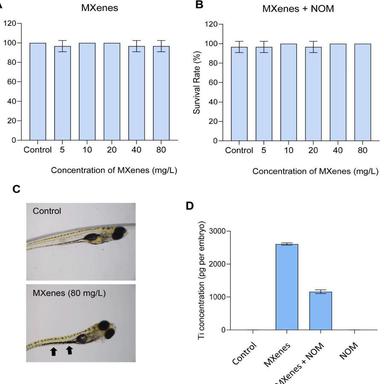
Survival rate of zebrafish embryos after exposure in EPA VS medium for 24 h to (A) MXenes alone, and (B) MXenes plus NOM (10 mg/L). Data are presented as mean values ± S.D. of three independent experiments (30 embryos per experiment). Student's t-test was used for the analysis of the comparisons between control and the indicated exposures (p < 0.05, p < 0.01, p < 0.001). (C) Representative images of zebrafish embryos after 24 h exposure in medium alone or MXenes (80 mg/L). Dark material (presumably MXenes)